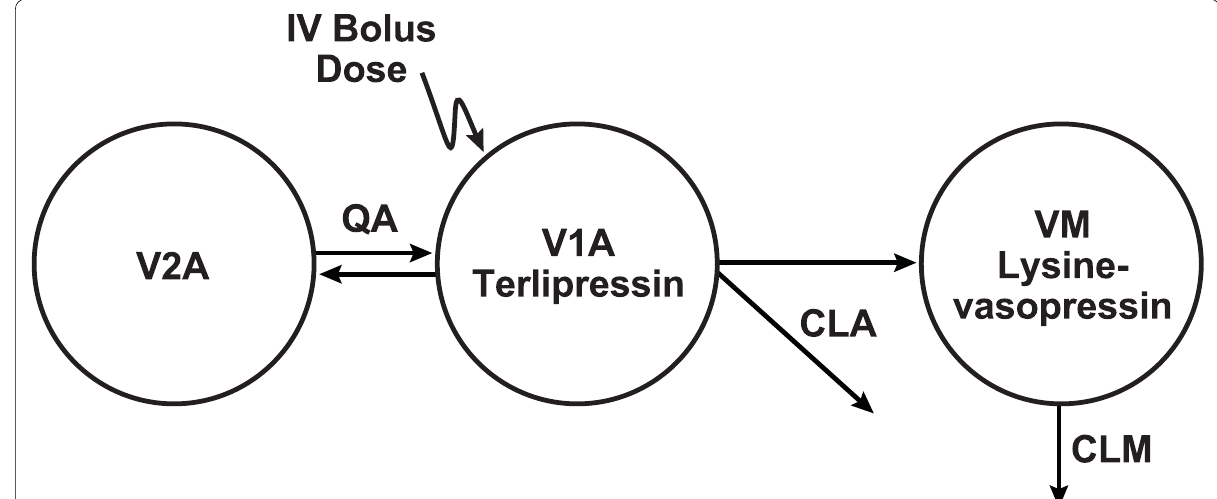
Fig. 1 Structural pharmacokinetic model for terlipressin and its active metabolite lysine-vasopressin. CLA , total body clearance for terlipressin; CLM/ Fm and VM/Fm , apparent volume of central compartment and clearance for lysine-vasopressin; IV , intravenous; QA , intercompartmental flow rate; V1A , central volume of distribution for terlipressin; V2A , peripheral volume of distribution for